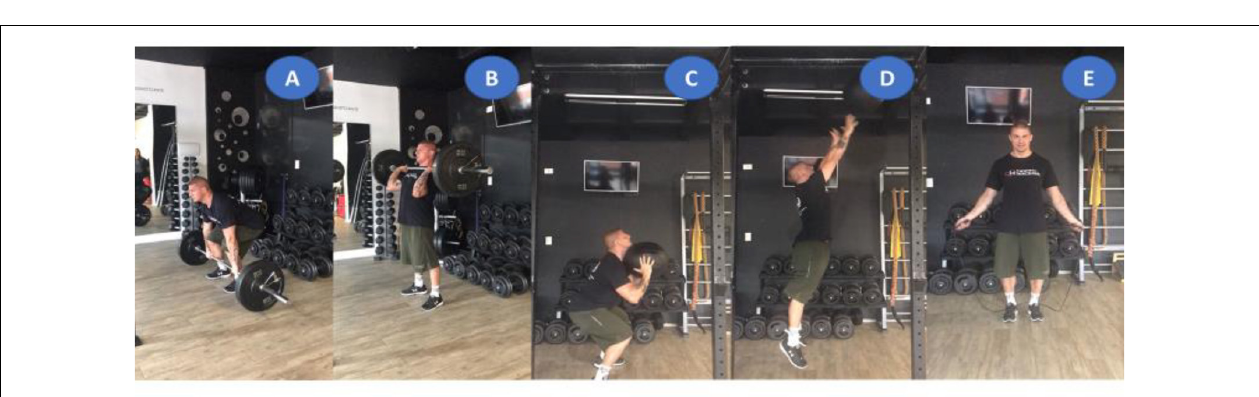
FIGURE 2 | Illustration of general body warming composed of three jump air squat (A,B) and kettlebell swing (C,D) movements. The consent for both the study participation and publication of the images was both written and informed for all the participants.